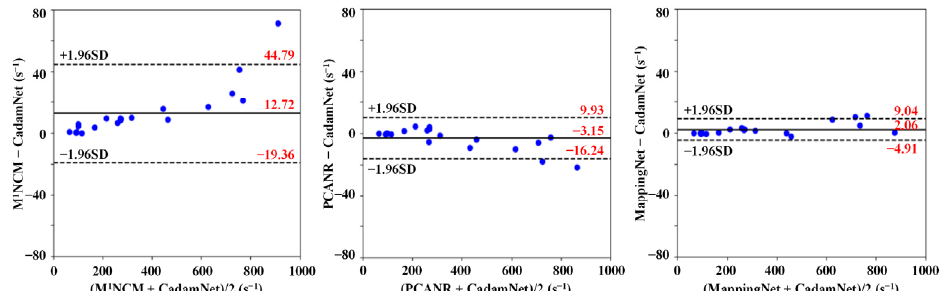
Figure 8. Bland–Altman analysis for the agreement of the mean R2* values in liver parenchyma (excluding vasculature) from different methods for clinical datasets. The blue dots denote the subjects in the clinical liver datasets. The solid lines represent mean differences, and the dashed lines indicate 95% confidence intervals.